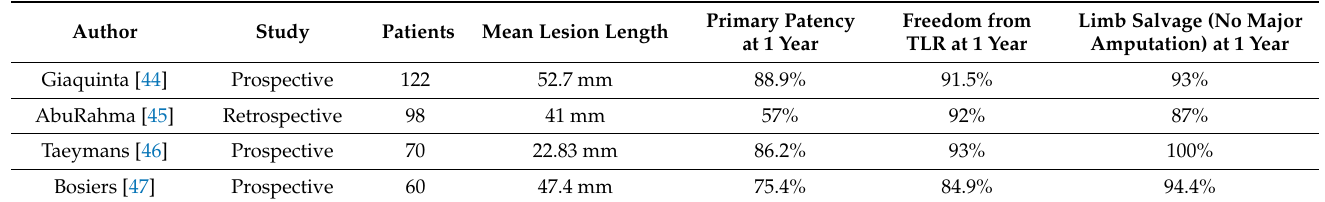
Table 4. Summary of primary endpoints of everolimus drug eluting stents of above